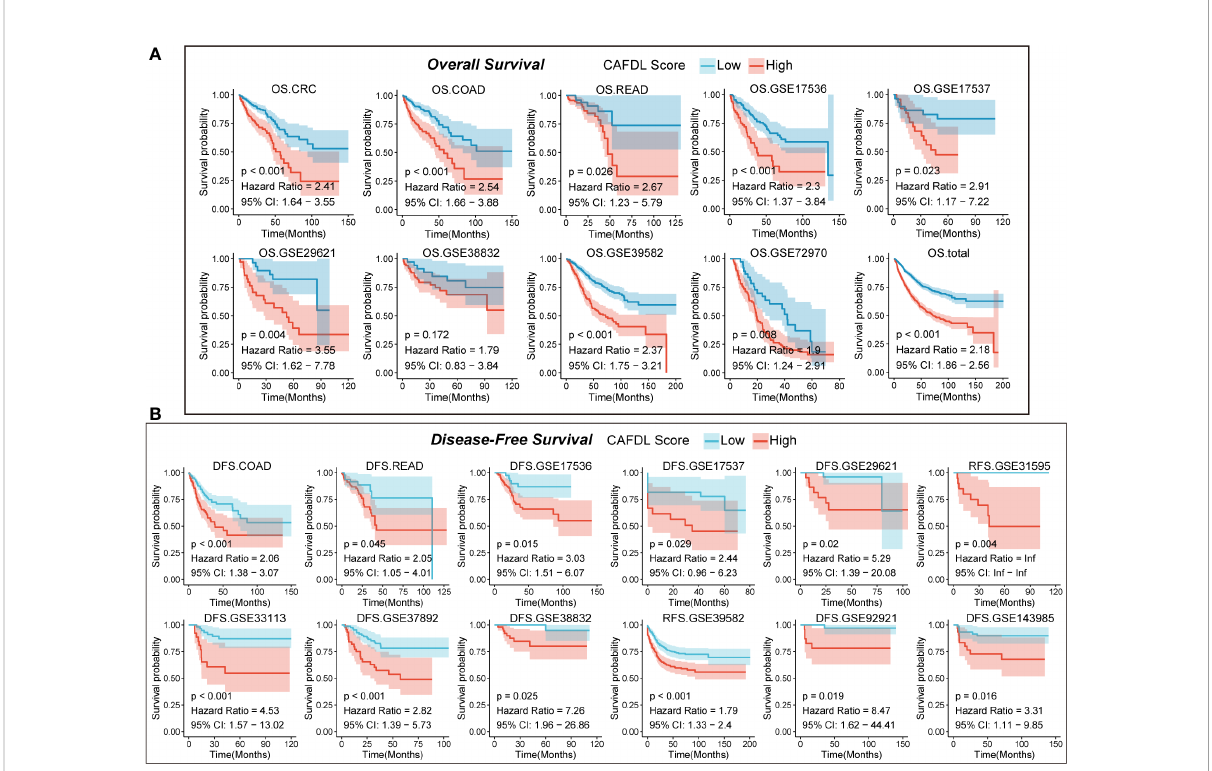
FIGURE 3 CAFDL signature can effectively predict the prognosis of patients with CRC. (A) Patients with high CAFDL scores have signi fi cantly worse overall survival than those with low CAFDL scores in TCGA-CRC, TCGA-COAD, TCGA-READ, GSE17536, GSE17537, GSE29621, GSE38832, GSE39582, GSE72970, and total CRC cohorts. (B) Patients with high CAFDL scores have signi fi cantly worse disease-free survival than those with low CAFDL scores in TCGA-COAD, TCGA-READ, GSE17536, GSE17537, GSE29621, GSE31595, GSE33113, GSE37892, GSE38832, GSE39582, GSE92921, and GSE143985